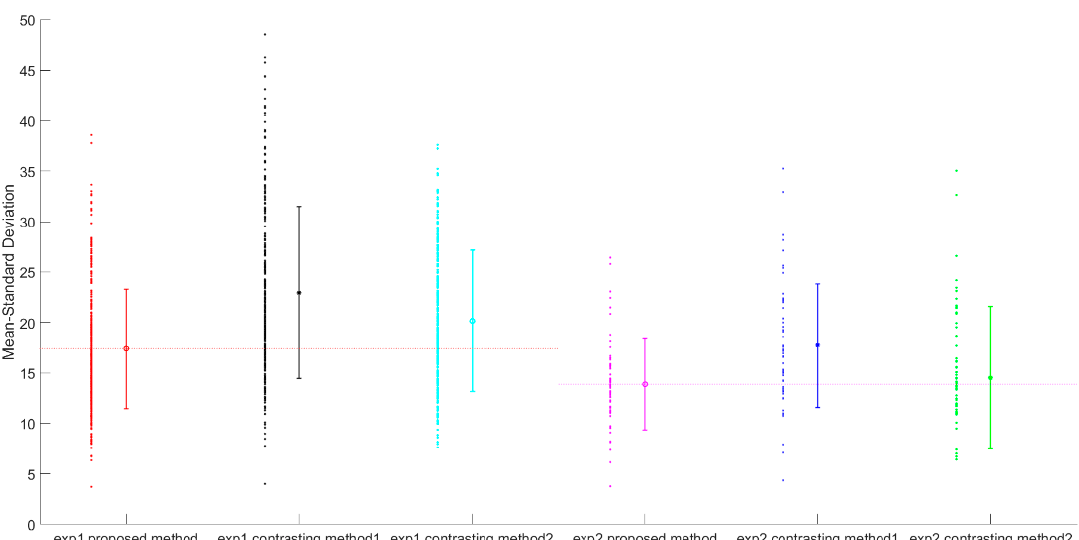
Figure 10. Means and standard deviations of the RMSE for our method (the optimized normalization strategy) and the two contrasting methods (the traditional normalization strategy with one reference image and the virtual reference image made up of the mean value); the left-side points indicate the RMSE between a single image pair, and the right-side lines indicate the means and standard deviations of the RMSE. Exp1 and exp2 represent experiment 1 and experiment 2, respectively.